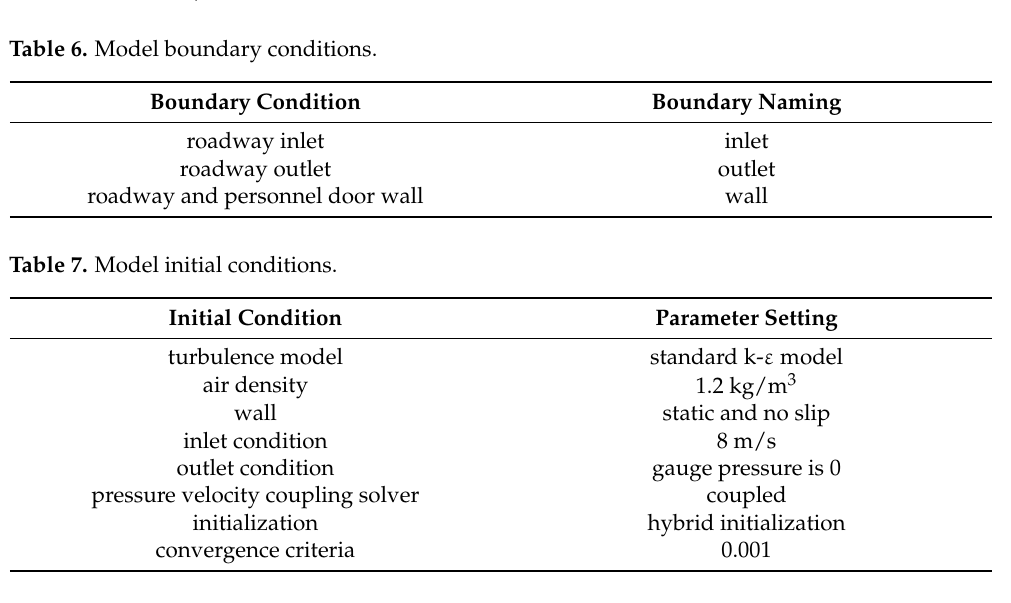
Figure 4. Two-dimensional roadway grid partition.